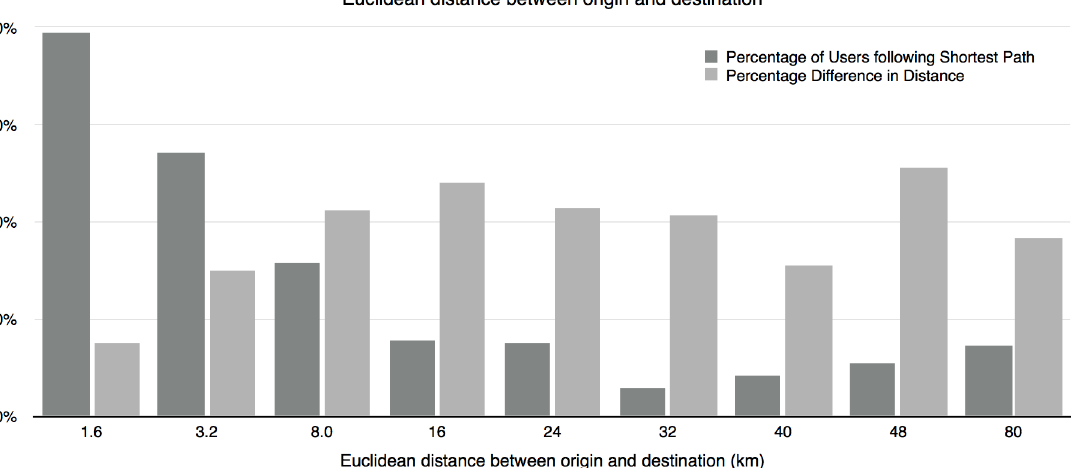
Fig 2. Percentage of trips in which travelers follow the shortest time path and percentage difference in length between the actual route and the shortest path by Euclidean distance between the origin and destination.